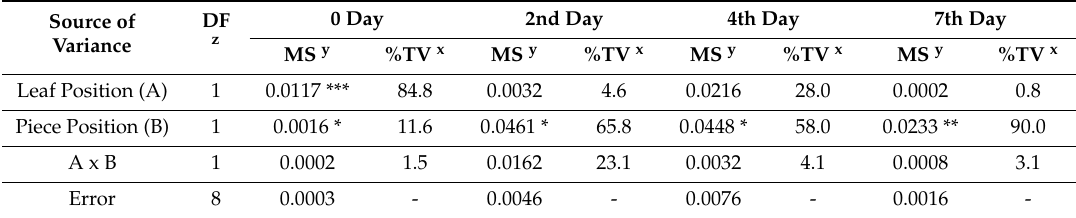
Table 3. Analysis of variance for the browning of fresh-cut ‘d’America rossastra’ butterhead lettuce, during storage at 10 ◦ C for 7